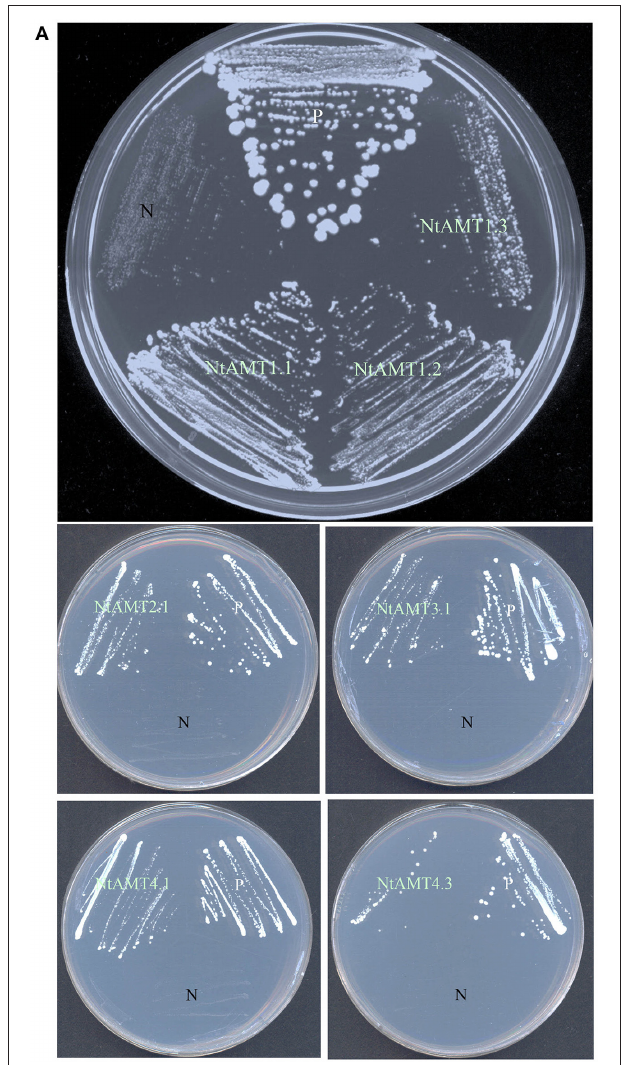
( Figure 4B ), and NtNRT1.2 reached its maximum